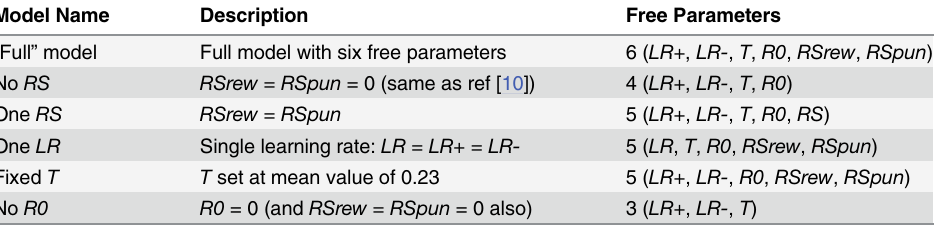
Table 2. Description and free parameters in each of the six models